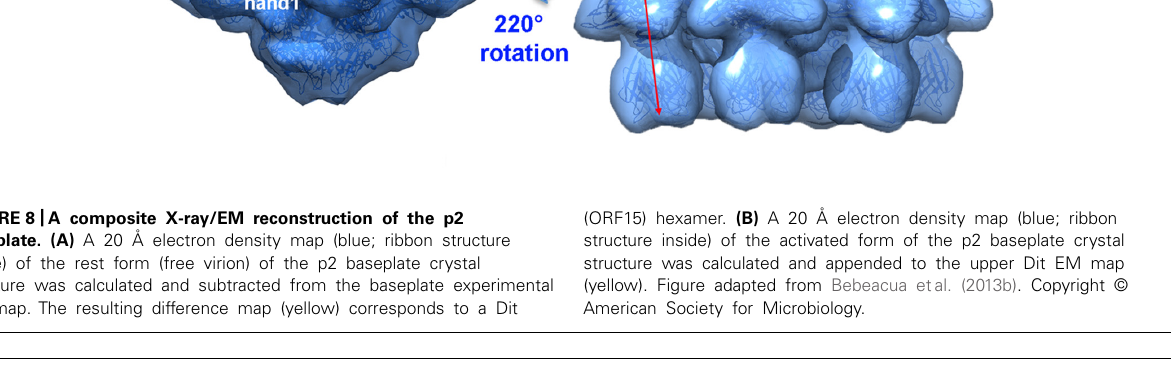
FIGURE 8 |A composite X-ray/EM reconstruction of the p2 baseplate. (A) A 20 Å electron density map (blue; ribbon structure inside) of the rest form (free virion) of the p2 baseplate crystal structure was calculated and subtracted from the baseplate experimental EM map. The resulting difference map (yellow) corresponds to a Dit